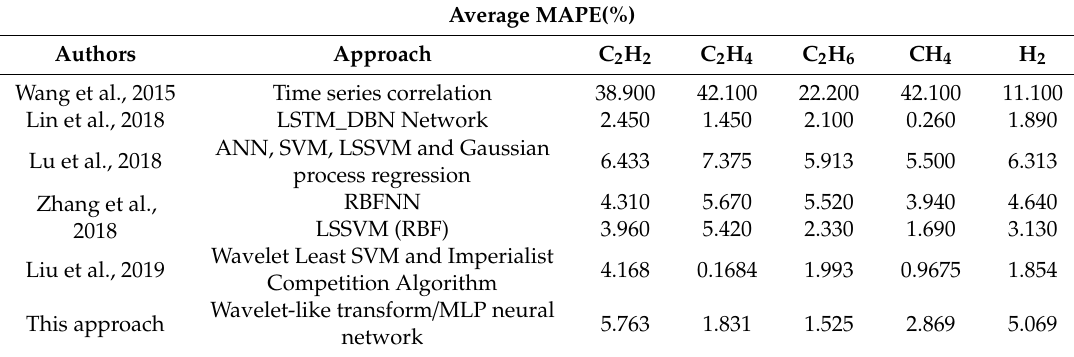
Table 8. Comparison of predicted gas